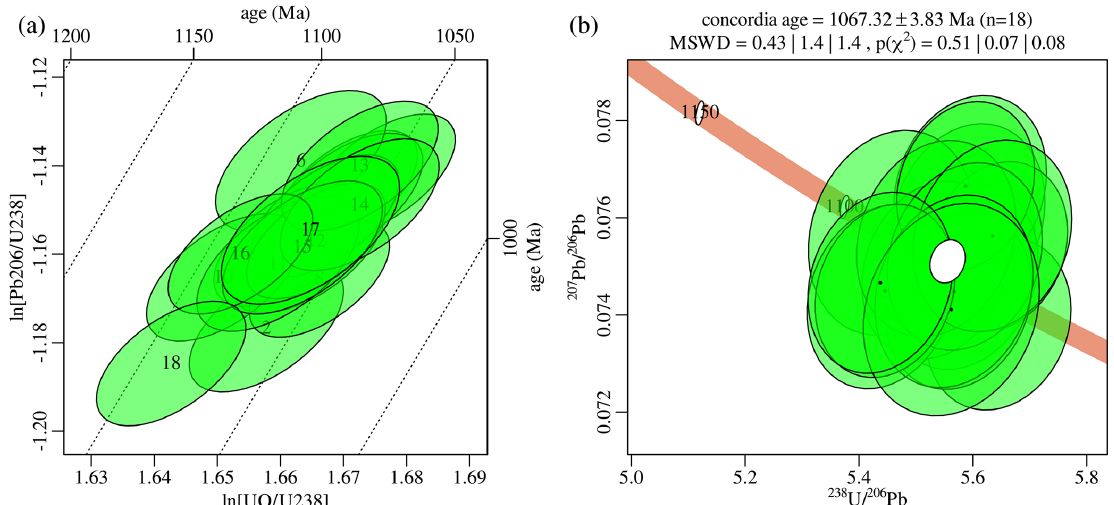
Figure 7. (a) Calibration plot of the SHRIMP 91500 zircon data using Temora2 as a reference material. Dotted lines are parallel to the regression line of Fig. 6b. (b) The same data shown on a Tera–Wasserburg concordia diagram, which was obtained with IsoplotR and does not take into account systematic errors associated with the calibration fit. All uncertainties are shown at 95% confidence. The white ellipse marks the weighted mean composition, with MSWD and p values representing the goodness of fit for equivalence, concordance, and equivalence + concordance.